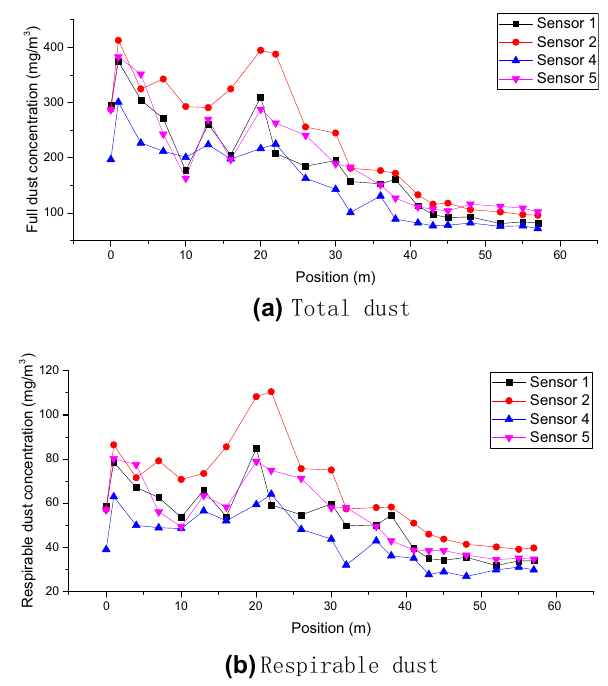
Fig. 8 Single-day total dust concentration and process